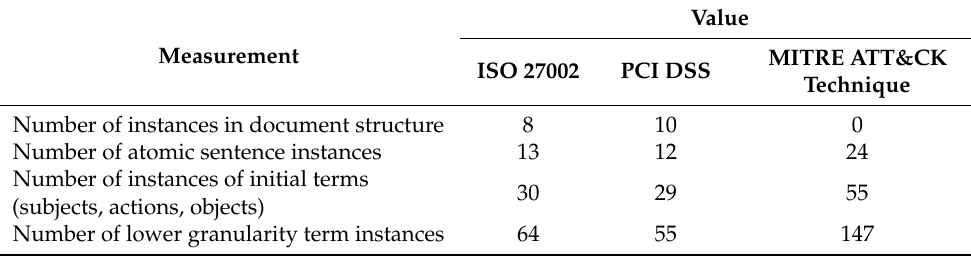
Table 1. Summary of the number of instances in sample data of the analyzed security documents. Measurement